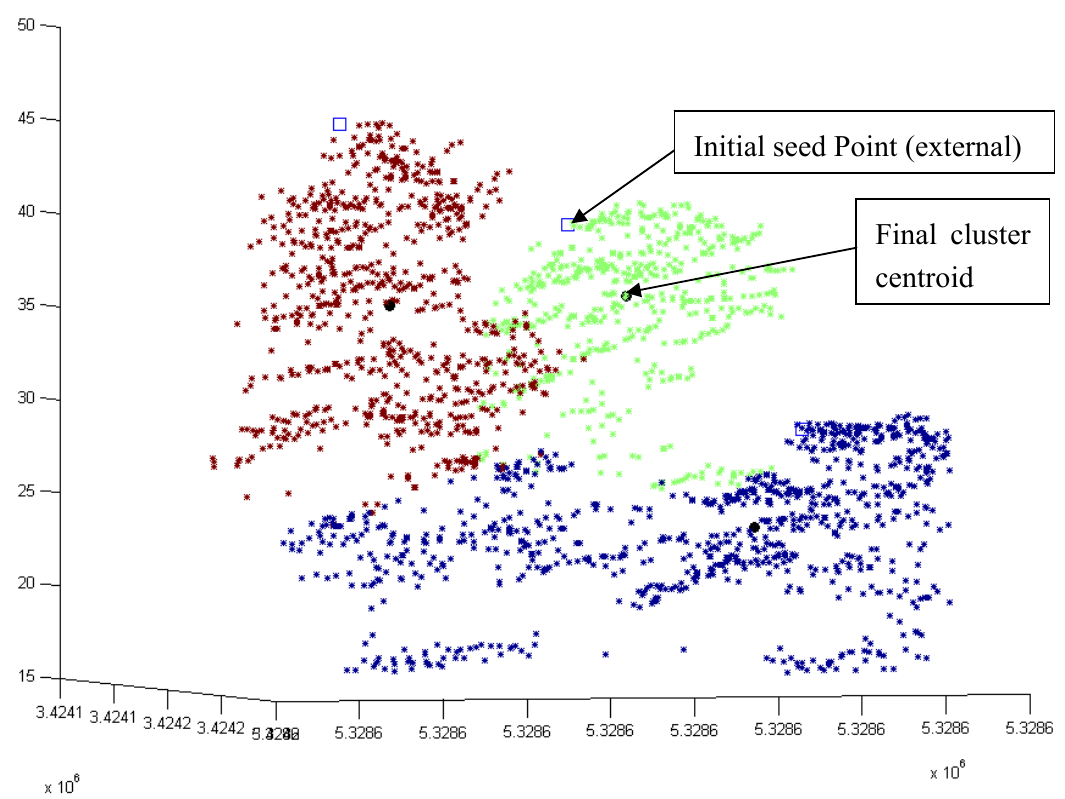
Figure 11. Result after running M k -means without scaling down the height value on Cell 6 datasets of height above 16 m. The x and y coordinate values (in meters) are displayed horizontally and the z value (in meters) is displayed